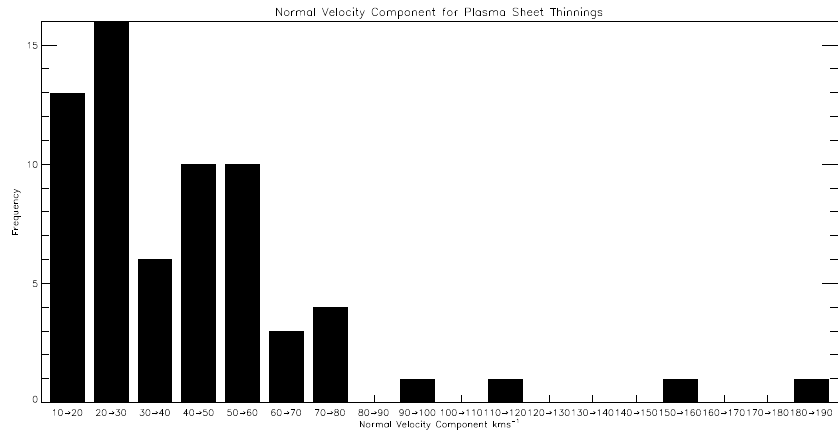
Fig. 15. A bar chart of the normal velocity component of all plasma sheet-lobe boundaries passing over the spacecraft associated with plasma sheet thinning. The speeds are binned into 10kms − 1 bins. The average is 48 ± 38kms − 1 .